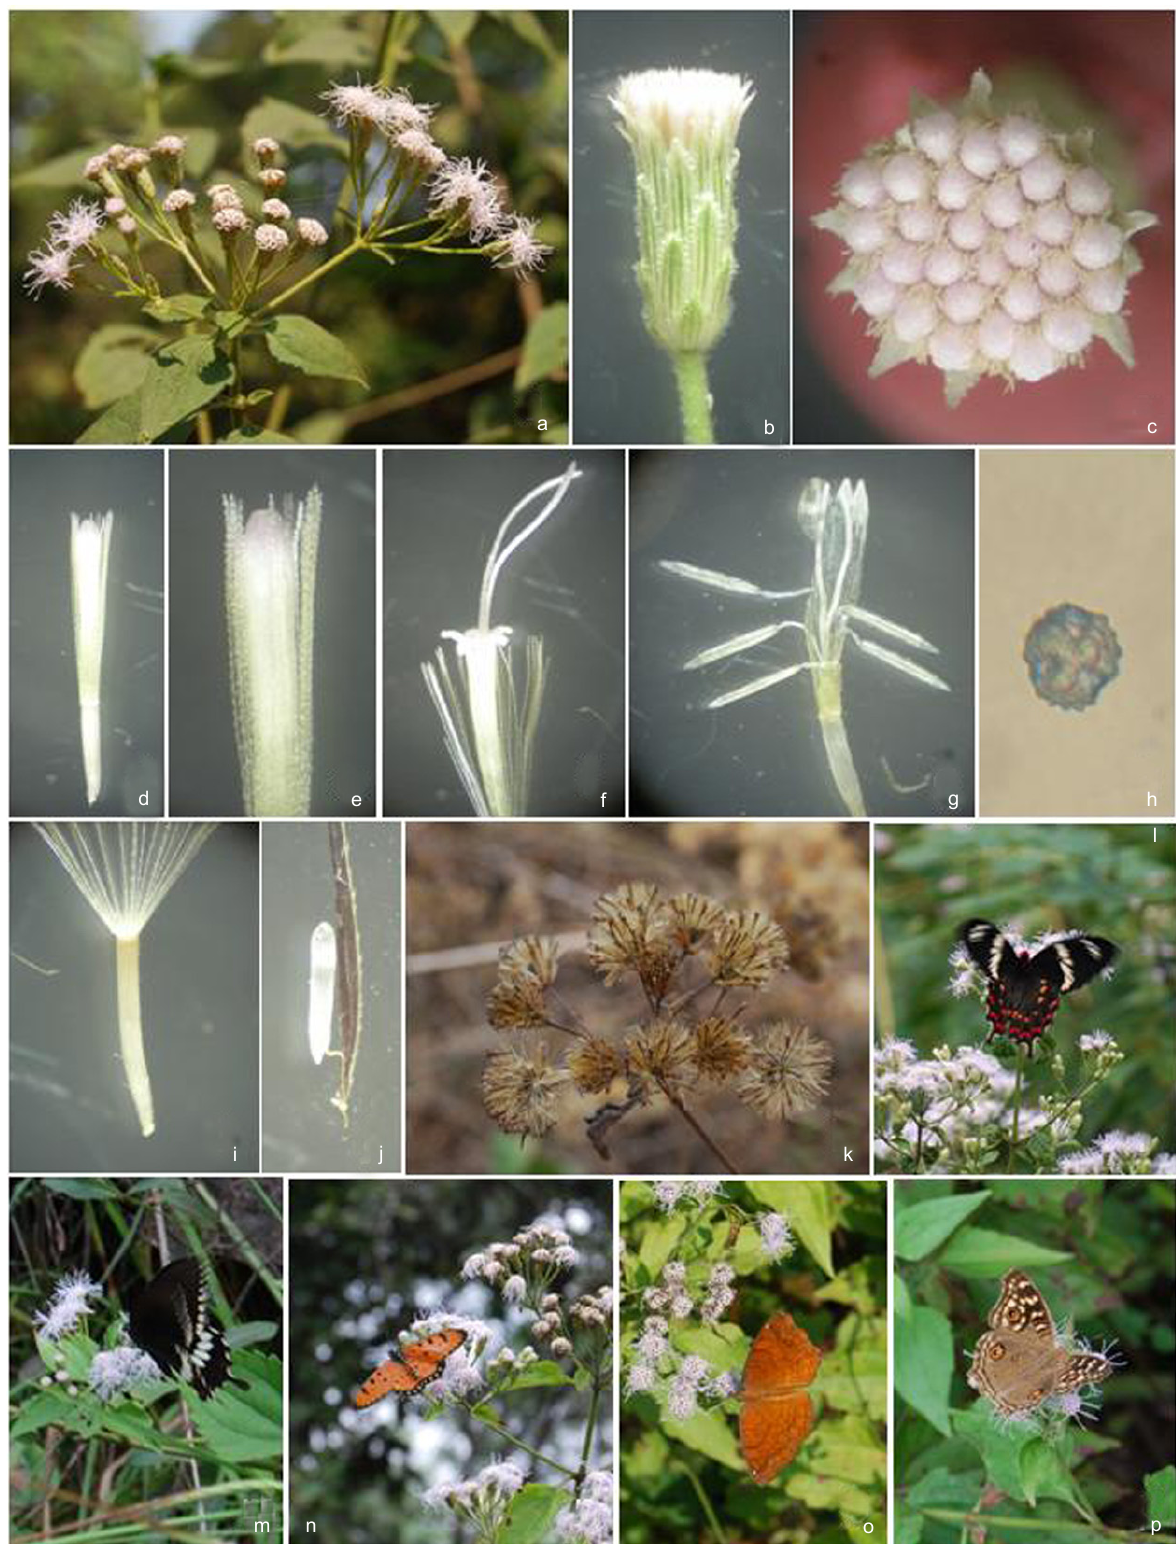
Image 1. Chromolaena odorata a - flowering inflorescences; b - individual cylindrical head; c - mature head; d & e - mature florets; f - open floret; g - l.s. floret; h - pollen grain; i - ovary; j - ovule; k - mature seeds ready for dispersal; l - Pachliopta hector ; m - Papilio polytes ; n - Acraea violae ; o - Ariadne ariadne ; p - Junonia